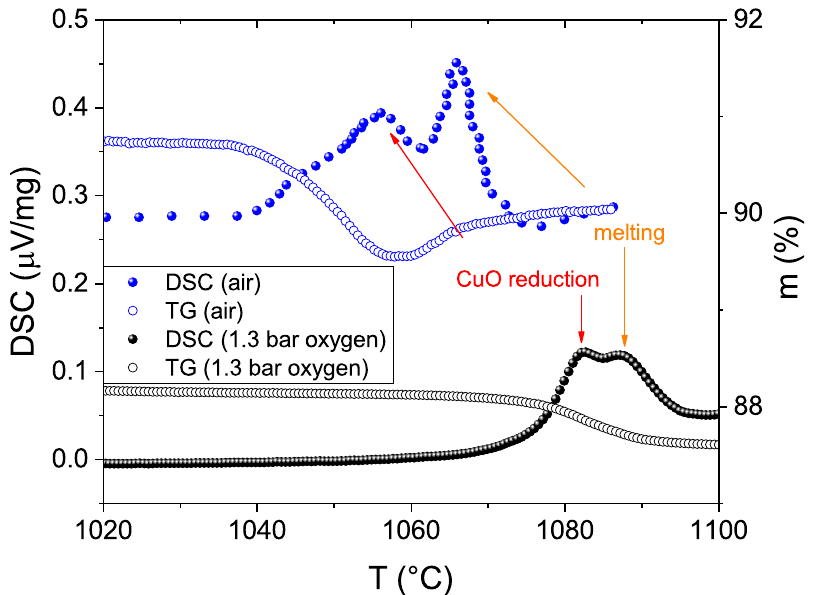
Figure 2. Differential scanning calorimetry/thermogravimetric (DSC/TG) measurement of a stoichiometric BaCO 3 , CuO, and 2 SiO 2 mixture upon heating in air and an oxygen partial pressure of 1.3